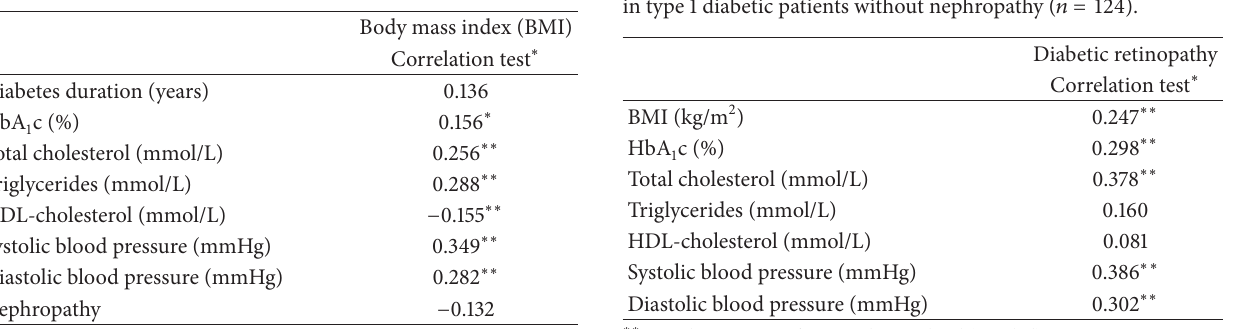
Table 6: Correlation between body mass index and metabolic and clinical parameters in type 1 diabetic patients ( 𝑛 = 176 ).